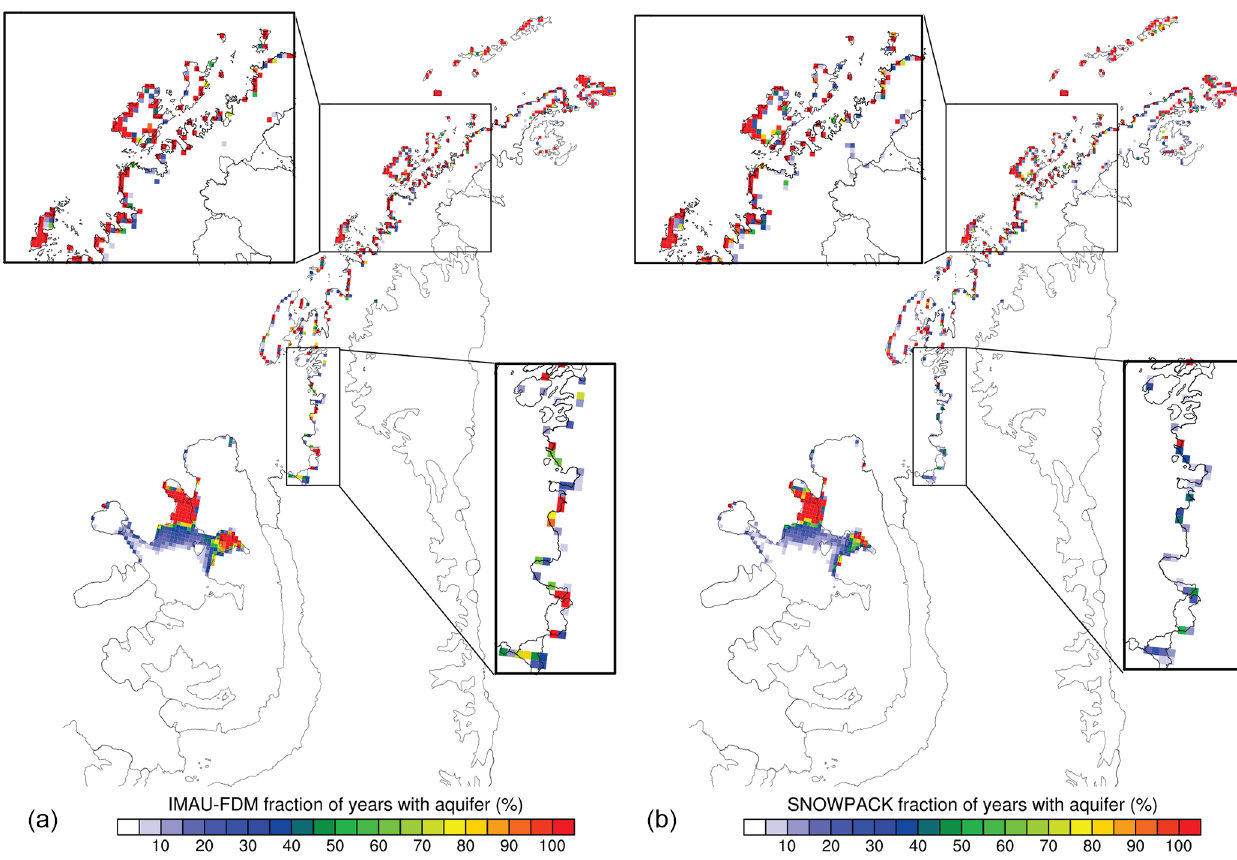
Figure 6. Modelled IMAU-FDM (a) and SNOWPACK (b) percentage of total years from 1979–2016 with vertically integrated liquid water content for PFA points; see text.